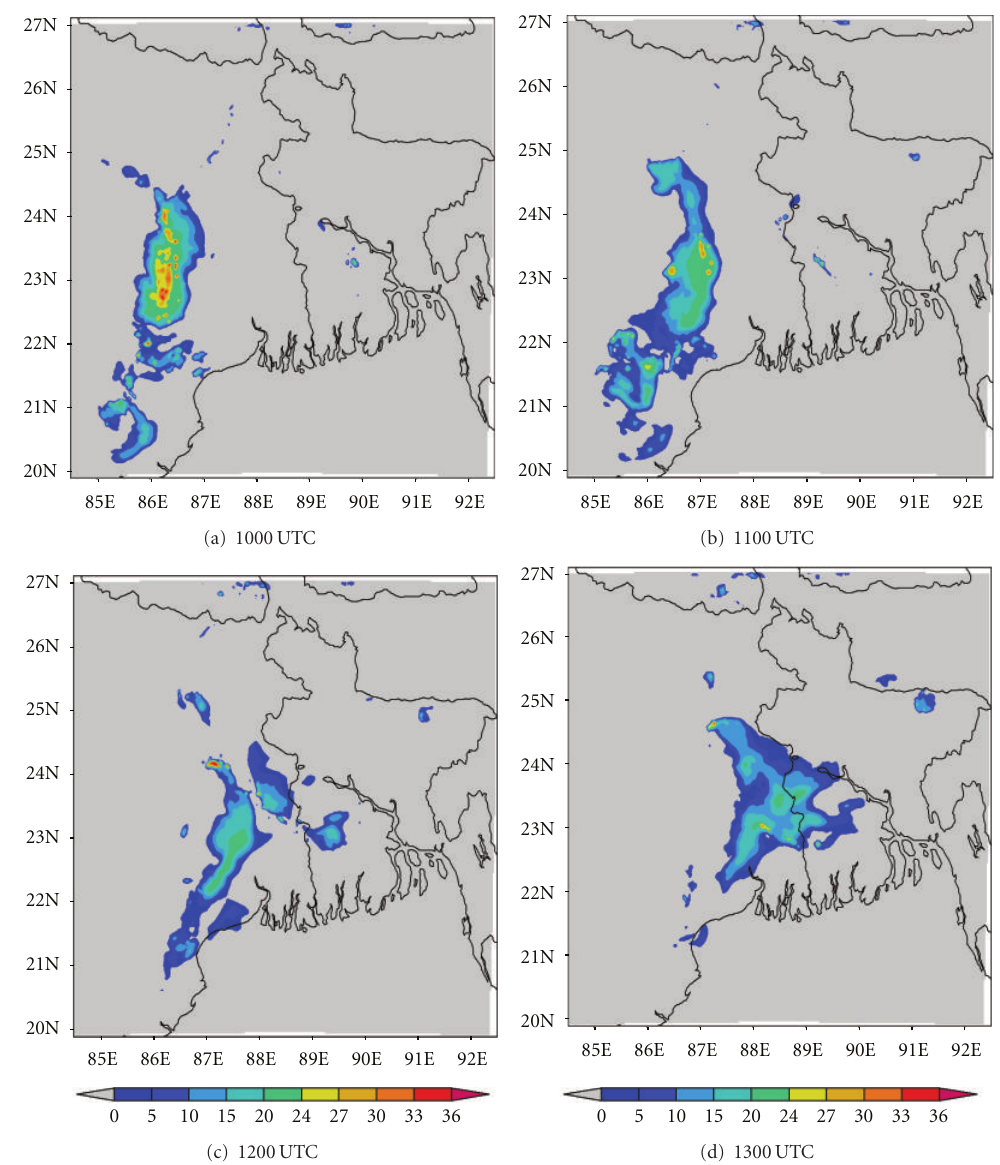
Figure 11: NMM-simulated composite radar reflectivity (dBZ) pictures from 1000 to 1300 UTC on 15, May,